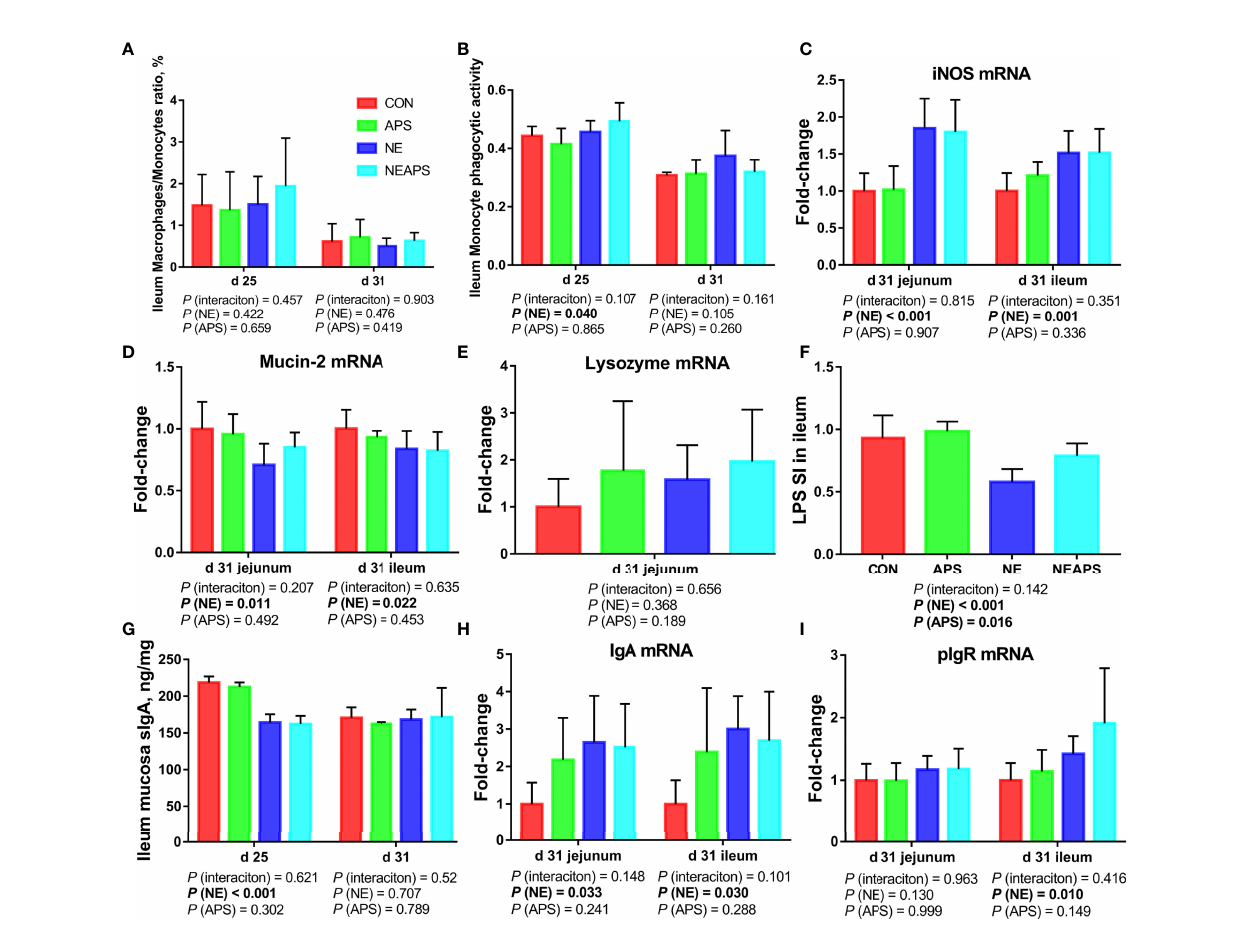
FIGURE 5 | Effects of dietary astragalus polysaccharides supplementation on intestinal nonspeci fi c immune function and humoral immune function of broiler chickens challenged with necrotic enteritis. The frequencies of Mononuclear/Macrophage (A) of ileum lymphocytes were analyzed by fl ow cytometry. The phagocytic activity of Monocytes (B) was analyzed by neutral red method. The mRNA levels of iNOS (C) , Mucin-2 (D) , lysozyme (E) , IgA (H) and pIgR (I) in jejunum and ileum were analyzed by RT-PCR. Ileum lymphocytes were stimulated with lipopolysaccharide (LPS) (F) , and the stimulation index (SI) was calculated as described in the Materials and Methods section. The level of sIgA of ileum mucosa (G) was analyzed by ELISA kit. All graphs are presented as mean, with the standard deviation (SD) shown via the whiskers. The main effect and interaction effects were analyzed using the general linear model (GLM) procedure, with the P values for the main effects written out below each plot. The one-way ANOVA and multiple comparisons were performed when interactive effects differed signi fi cantly. CON, control group; APS, APS group; NE, NE infection group; NEAPS, APS infected with NE